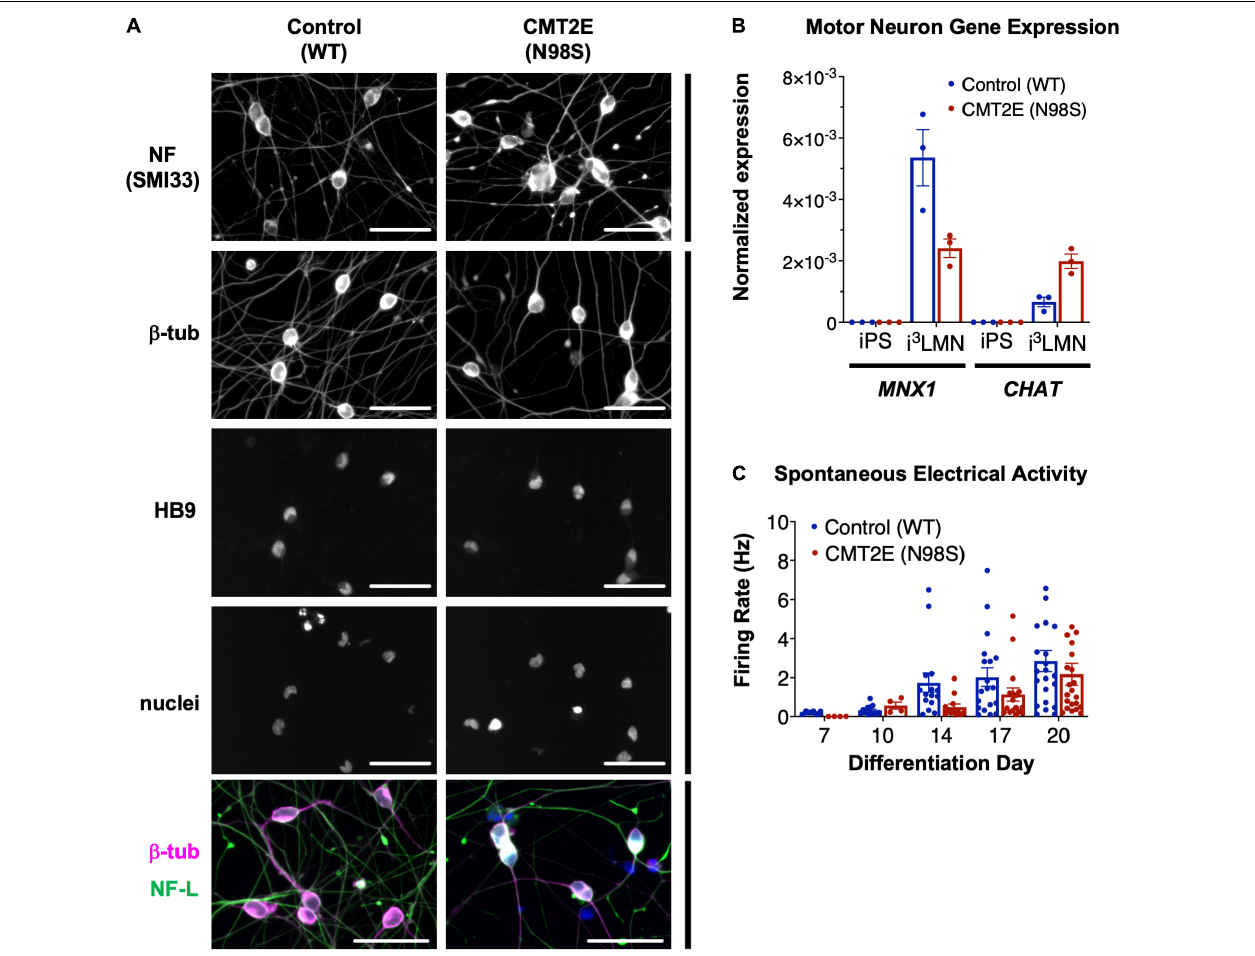
FIGURE 1 | Generation of CMT2E ( NEFL -N98S) motor neurons. (A) Expression of neuronal markers by immunofluorescent staining in day-7 i 3 LMNs derived from healthy control and CMT2E patient iPSC lines. Lower panels are separate RGB channels from the same images, as indicated by a vertical bar. Scale bars = 50 µ m. NF = neurofilaments (SMI33 antibody), NF-L = neurofilament light chain, β -tub = β III-tubulin, DAPI stain for nuclei. (B) Total mRNA isolated from undifferentiated iPSCs and day-7 i 3 LMNs was assayed by RT-ddPCR for expression of motor neuron specific genes MNX1 and CHAT , normalized to GAPDH . (C) WT and N98S i 3 LMN were seeded on an MEA plate on day 3 of differentiation and spontaneous electrical activity was recorded starting on day 7 and every few days until day 20. Graph represents serial measurements of the mean firing rate (frequency of action potentials) from replicate wells. MEA data were analyzed using a mixed effects model for repeated measurements (maximum likelihood method). There was a significant effect due to time ( p < 0.005) but no significant difference between cell lines. For all graphs individual replicate data points are shown with bars representing mean ±